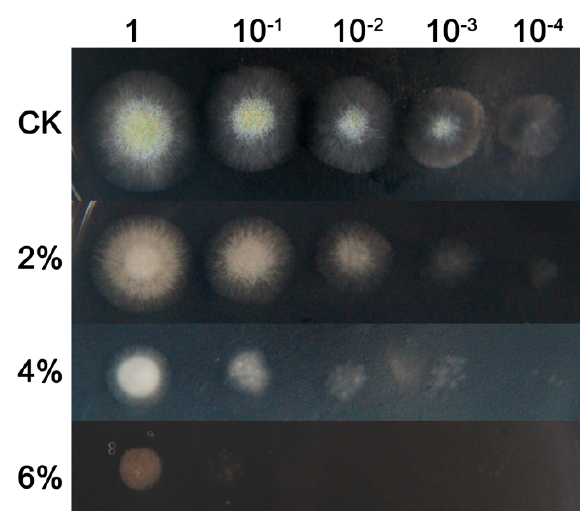
Figure 1. The inhibitory effect of ethanol variations at different concentrations (from 0% to 6%) on Aspergillus oryzae colonies at 48 h post-treatment. The suppression effect was determined in potato dextrose agar (PDA) solid medium by inoculating the serial dilutions of A. oryzae spores (from 1 to 10 -4 ).